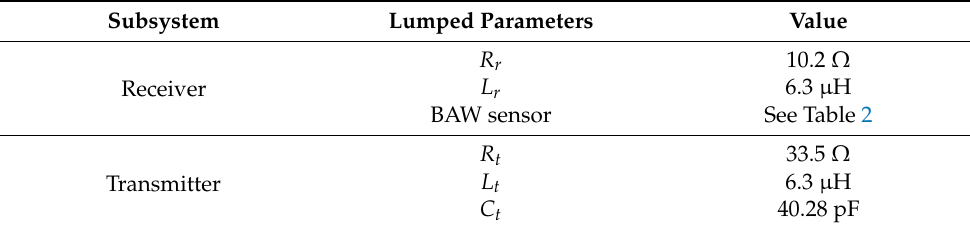
Table 3. The lumped parameters of a BAW passive wireless